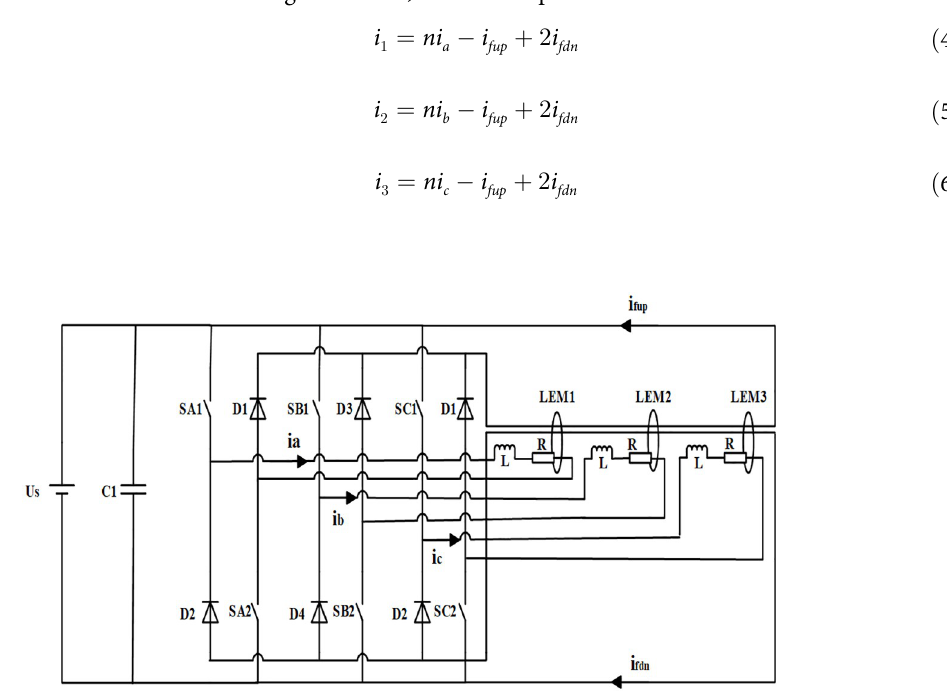
Fig 3. Switch equivalent circuit of the SRM power